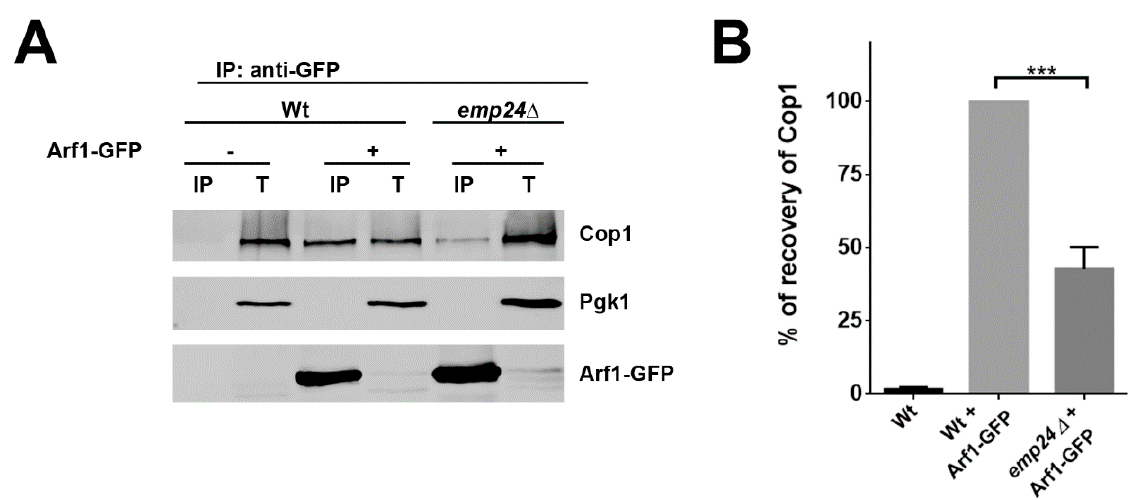
Figure 6. The p24 complex facilitates the interaction of Arf1-GFP with COPI. ( A ) Detergent-solubilized S13 fractions of wild-type and emp24 ∆ mutant cells expressing Arf1-GFP were subjected to native immunoprecipitation (IP) with anti-GFP antibody, followed by immunoblotting. Total (T) represents a fraction of the solubilized input material. ( B ) Quantification of three independent experiments. The graph plots the average percentage of the recovery of Cop1 normalized to the recovery in the wild-type strain. Error bars indicate the SD. Statistical significance was determined by using the Student t test. *** p < 0.001.